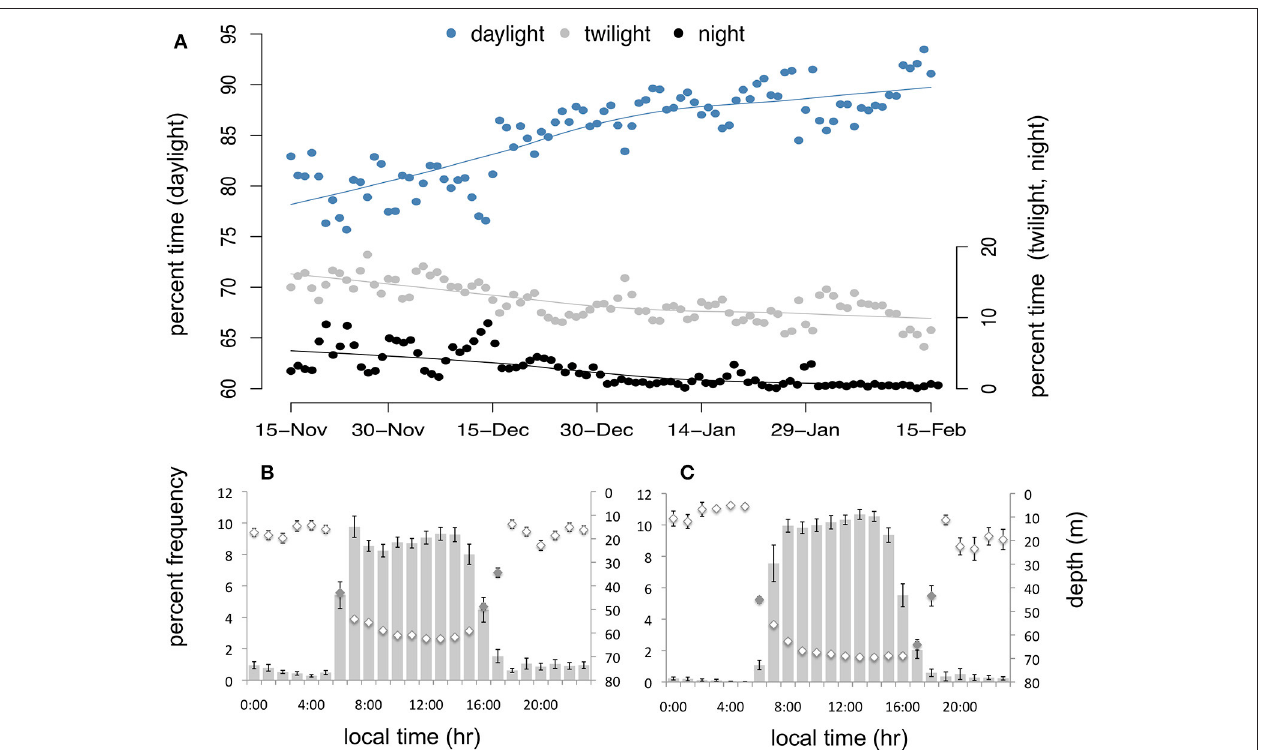
FIGURE 6 | (A) Proportion of total daily dive activity occurring during daylight (blue), twilight (gray), and night (black) over time in winter (with a loess smoothing function for each light period). Mean percentage number of dives (bars) and mean dive depth (diamonds; inverted y-axis) according to time of day (local time) during early winter (B) and late winter (C) . Gray diamonds (B,C) indicate approximate transitional hours during twilight (i.e., sun angle ≥ -12 and ≤